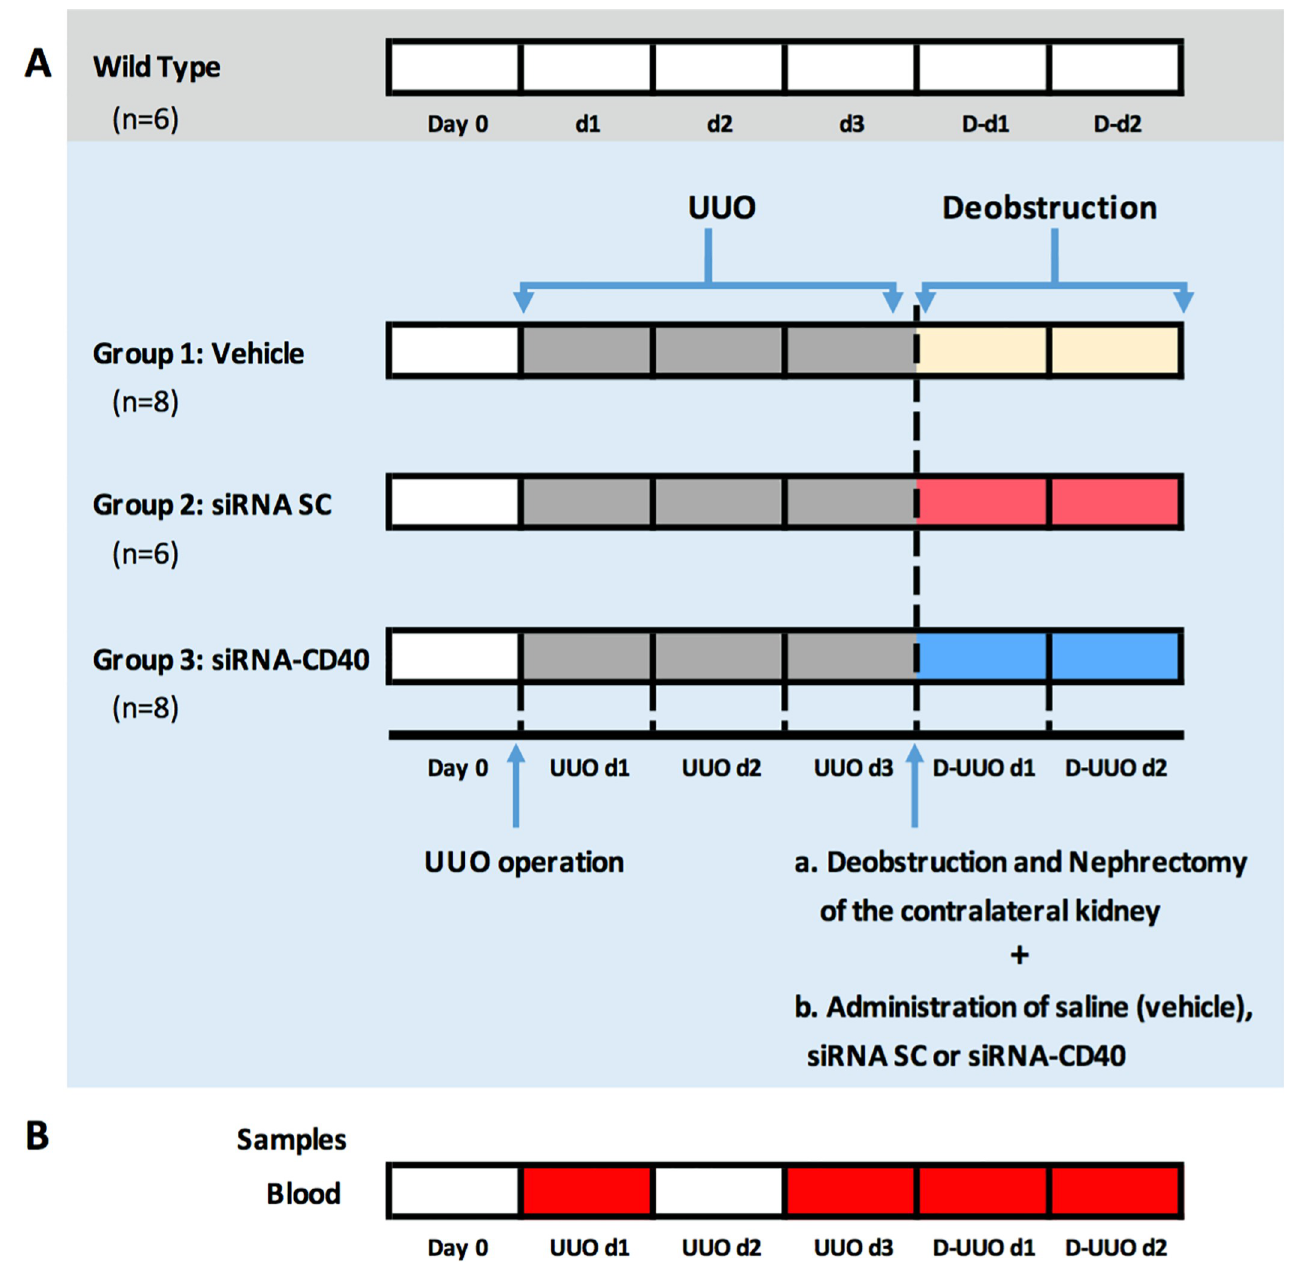
Fig 1. Scheme of the experimental design for the four groups of studied mice. (A) WT and groups 1 (Vehicle), group 2 (siRNA SC) and group 3 (siRNA CD40) where the D-UUO was performed with the administration of Vehicle, siRNA SC or siRNA CD40. ( B). Blood samples were obtained at days UUO d1, UUO d3, D-UUO d1 and D-UUO d2.